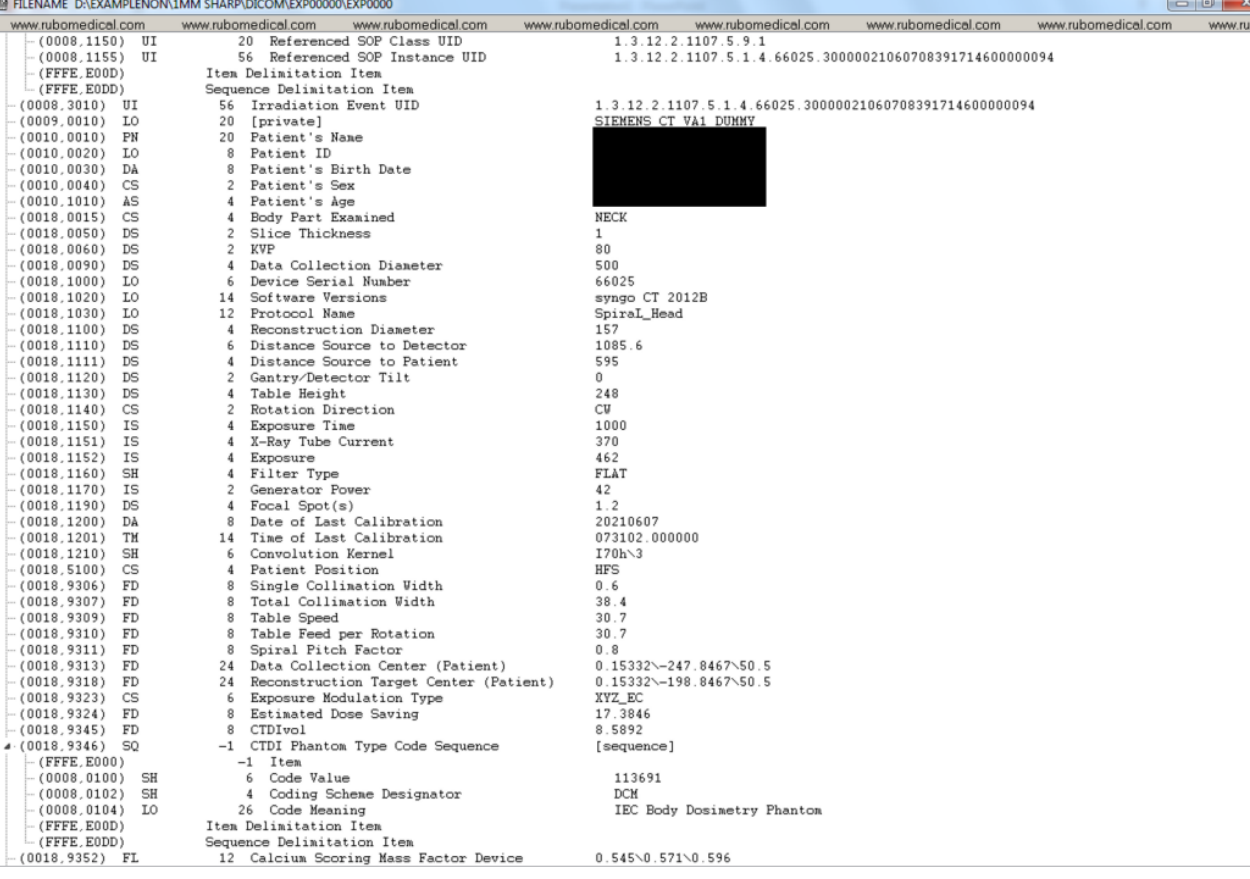
Figure A2. DICOM header data before de-identification (part